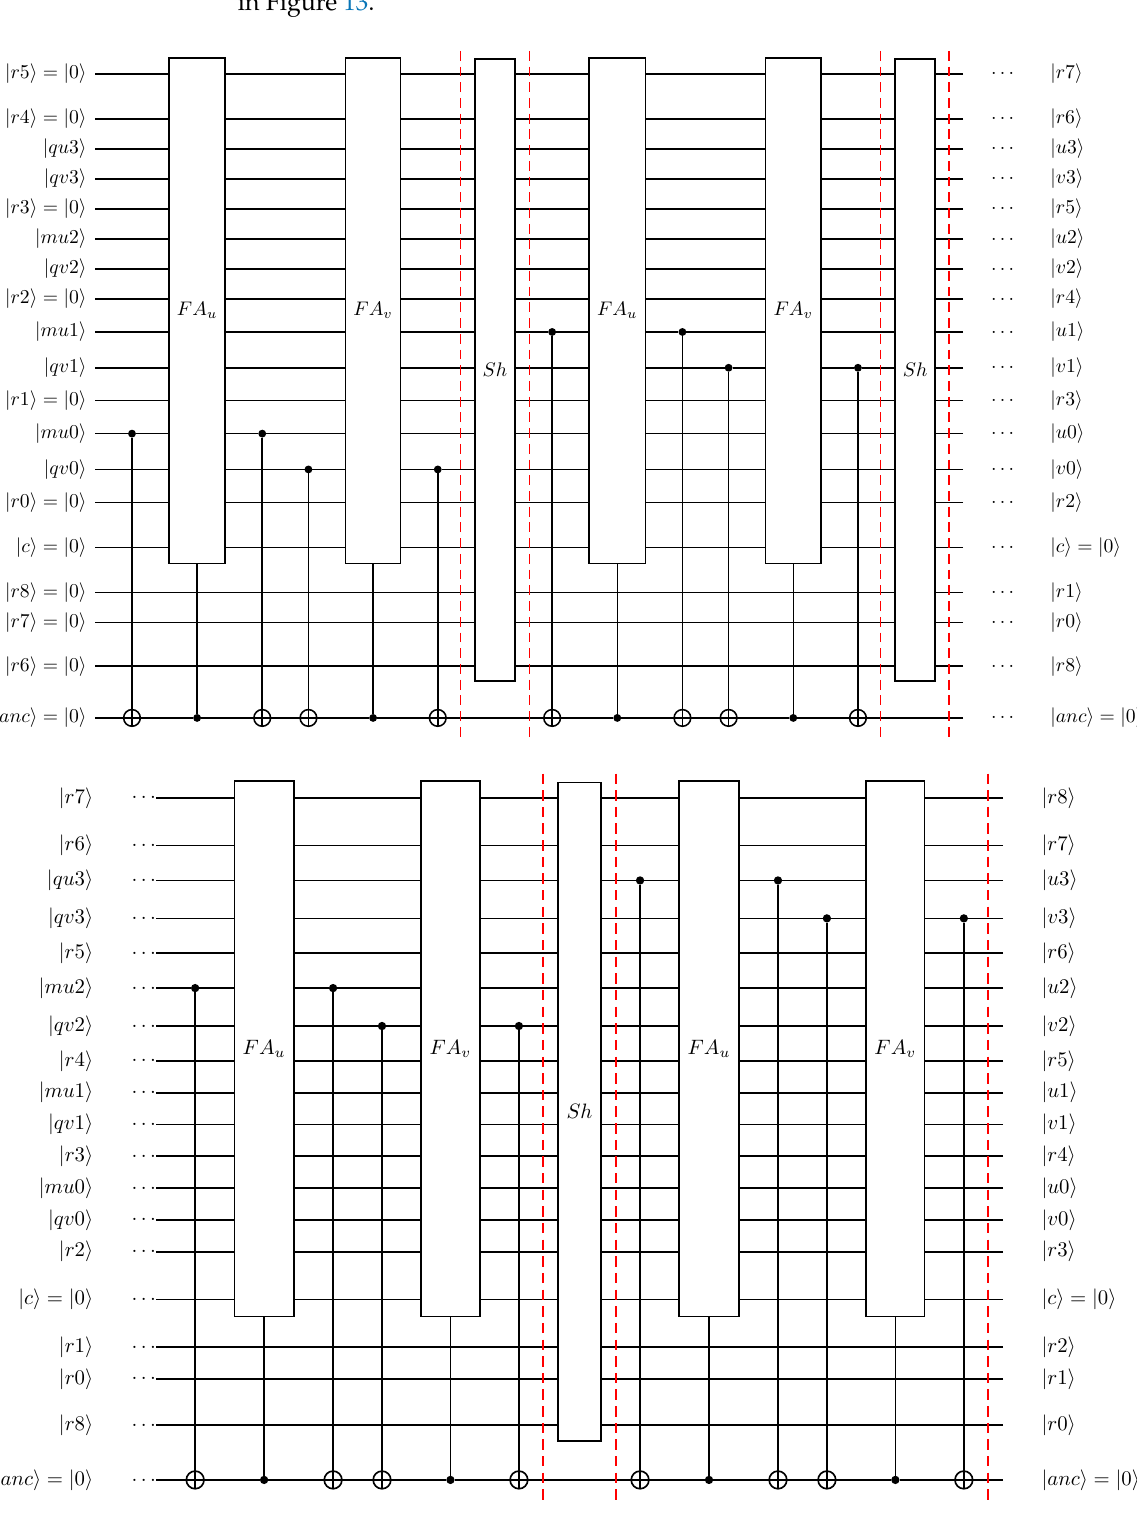
qubit mantissa squaring output register- SQ 4 −